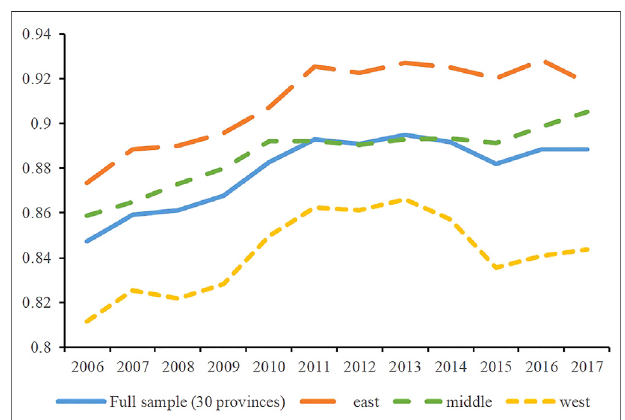
FIGURE 3 | The average value of UEIg in different regions.